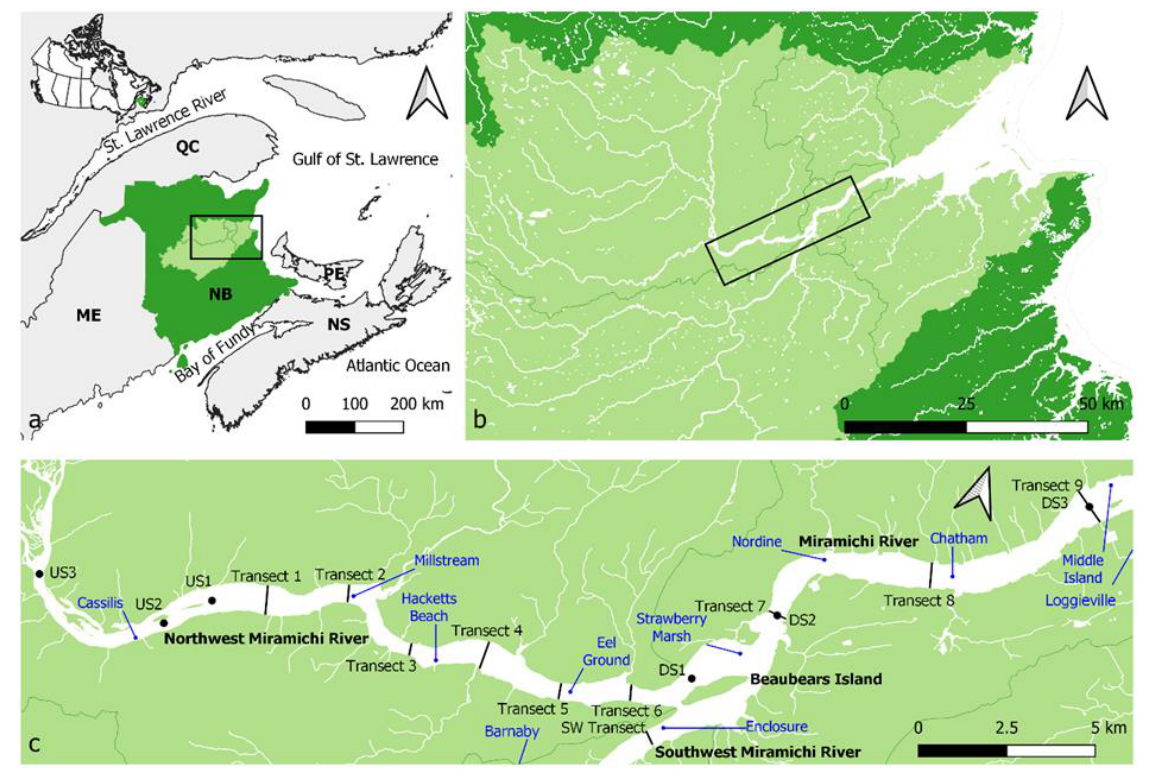
Figure 1. Map of the study area and sampling sites: ( a ) map of Quebec (QC), New Brunswick (NB), Prince Edward Island (PE), Nova Scotia (NS) and Maine, USA (ME), with New Brunswick in dark green and the Miramichi watershed in light green, ( b ) fine-scale view of waterbodies in the Miramichi watershed with the study area framed, ( c ) fine-scale view of the sampling sites with transects, upstream (US) and downstream (DS) sites, and acoustic receivers (blue) indicated. The Loggieville and Barnaby receivers are located 5.5 km downstream of the Middle Island receiver and upstream of the SW transect, respectively.